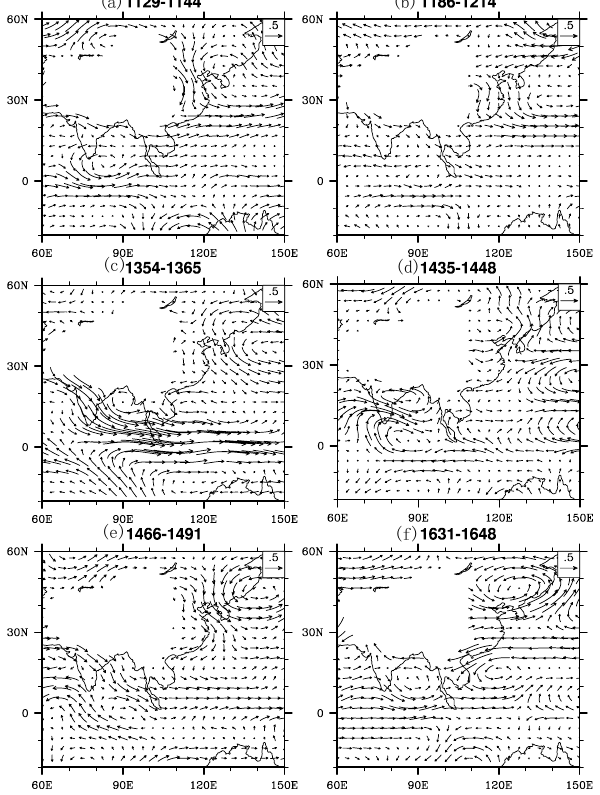
Figure 4. Same as Fig. 2 but for the wind at the level of 850hpa for the six well-captured droughts.